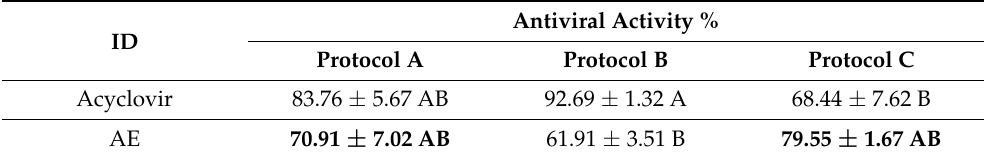
Table 5. Antiviral efficacy of the Annona glabra extract versus HSV1 vs. acyclovir, and protocols in parameters of cell viability values (M ±